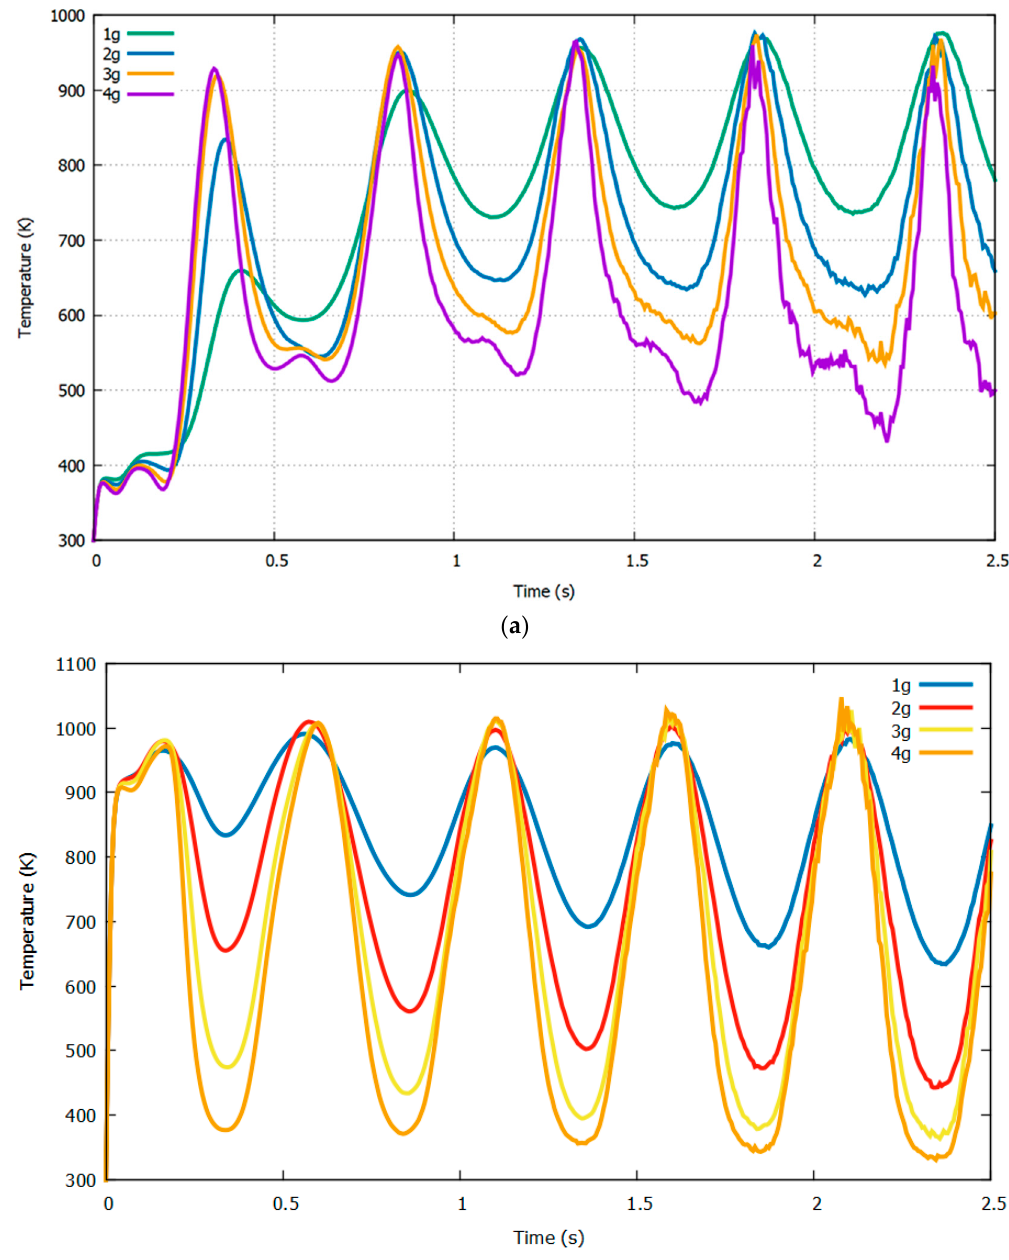
Figure 7. Temperature response of sensors Y32 ( a ) and Y31 ( b ) at 4 π rad/s with varying acceleration.